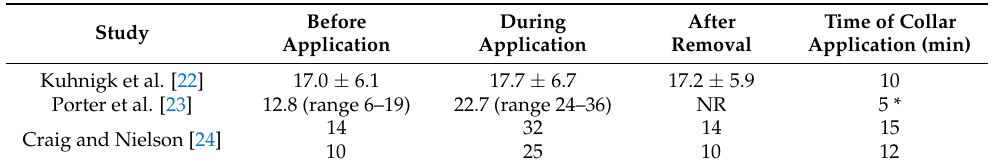
Table 5. ICP measurements (mean ± SD/mmHg) before, during, and after the application of cervical collars from additional studies.